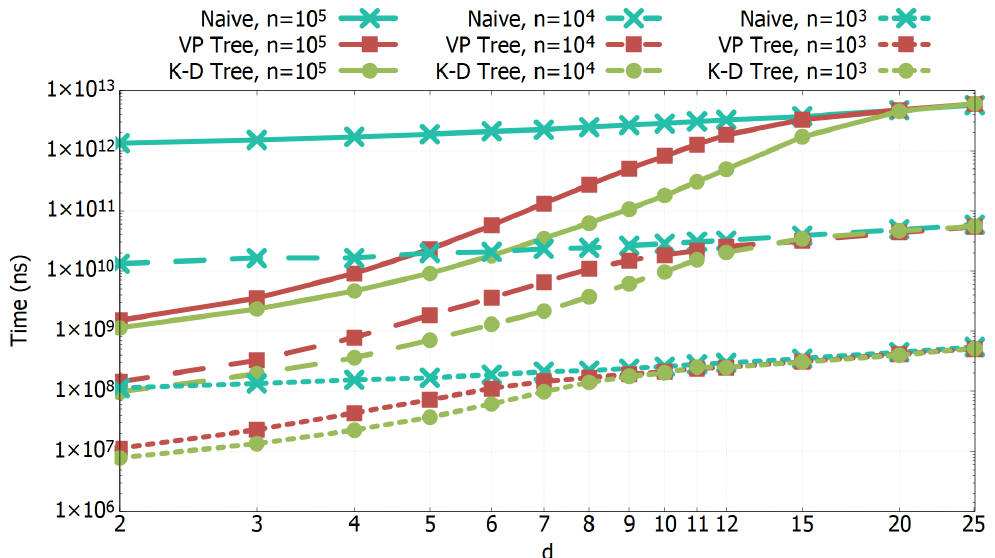
Figure 4. Computational times comparison of the all- k -nn algorithms as the number of dimensions d grows. k = 20, three different values of n are used to show that the efficiency of the algorithms is lost ( n ) . Double logarithmic at about d = log 2